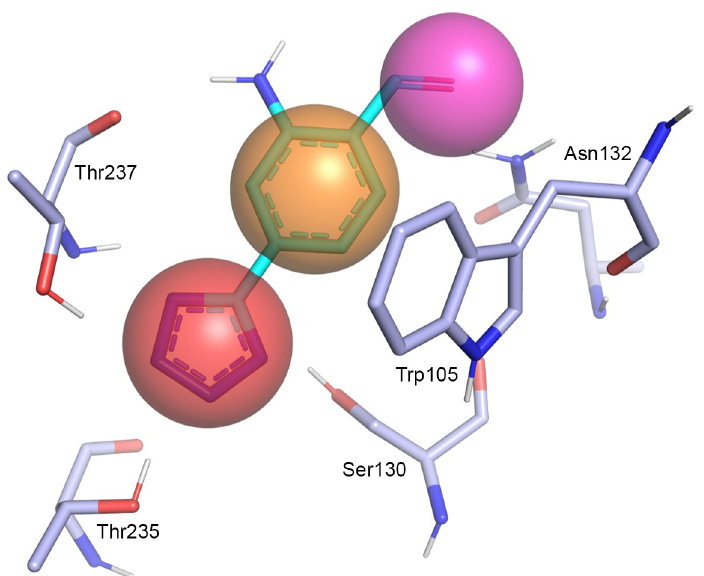
Fig 3. Pharmacophore hypothesis for KPC-2 ligands. Binding site of KPC-2 (PDB code 3RXW, blue) superimposed with a fragment of the ligand OJ6 bound to CTX-M-9 β -lactamase (PDB code 4DE1, cyan) and pharmacophore features (red: hydrogen-bond acceptor, orange: hydrophobic interaction feature, purple: hydrogen-bond donor) (Ambler numbering) [21].